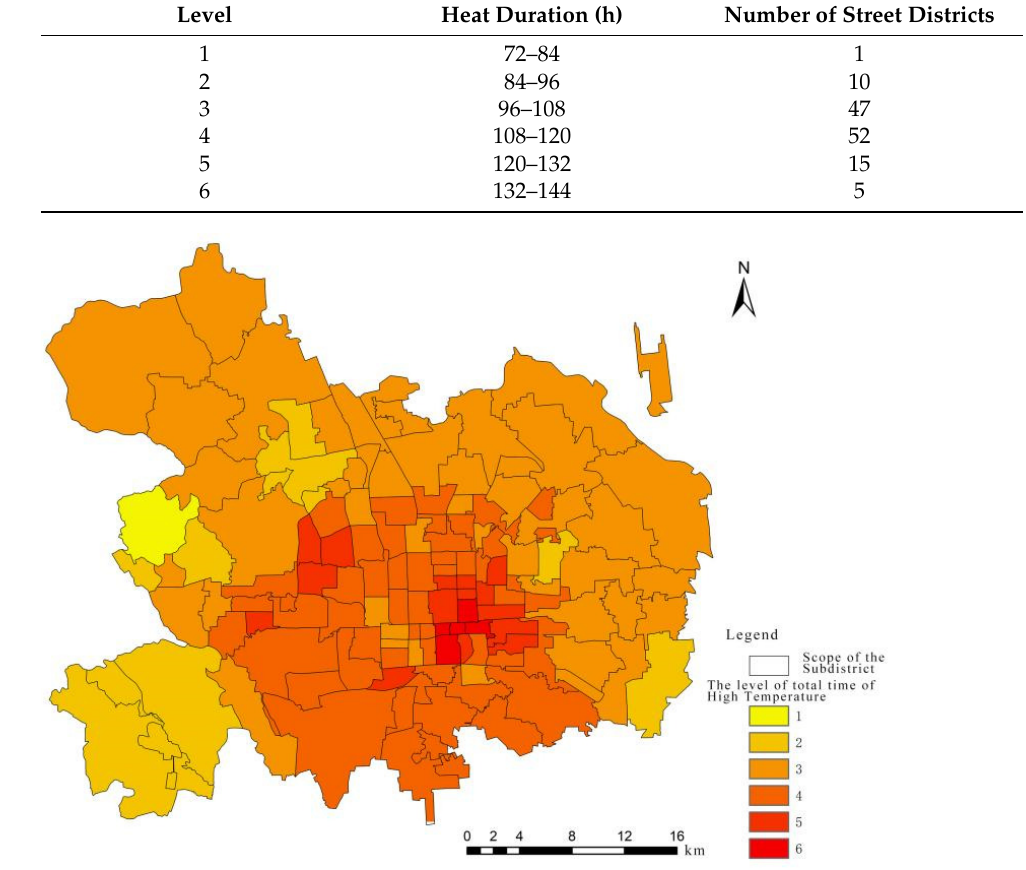
Table 1. Statistics of the heat duration distribution in the central urban area of Beijing.